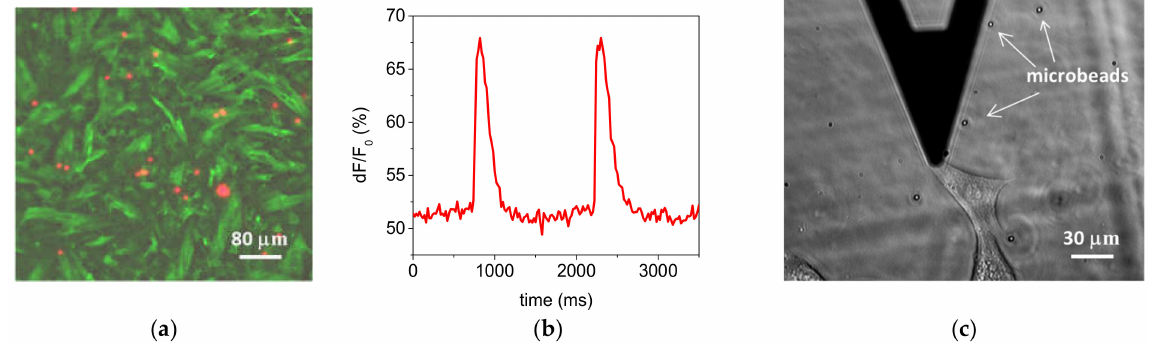
Figure 9. Optical performance of the combined setup. ( a ) Fluorescent micrograph of adherent cardiac myocytes cultured on the cell stretcher device; ( b ) beating cycle reconstructed from time-lapse fluorescence micrographs showing time-dependent calcium flux variations and ( c ) phase contrast micrograph of a 3T3 fibroblast and few microbeads (dark triangular object is the AFM cantilever).